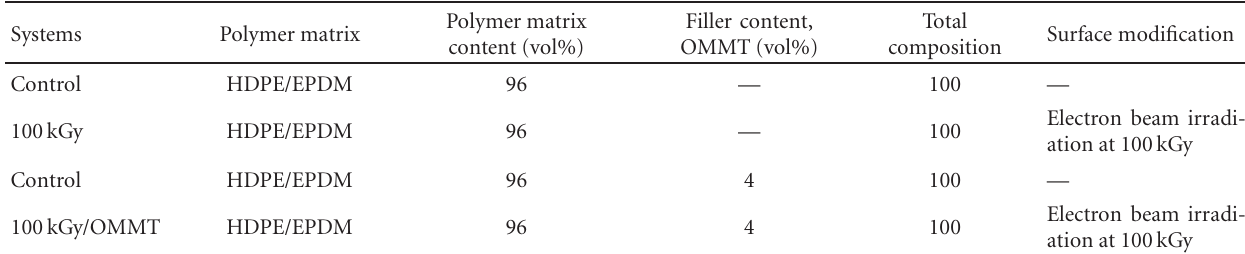
Table 2: Preparation of HDPE/EPDM and HDPE/EPDM filled with OMMT via melt blending method. Systems